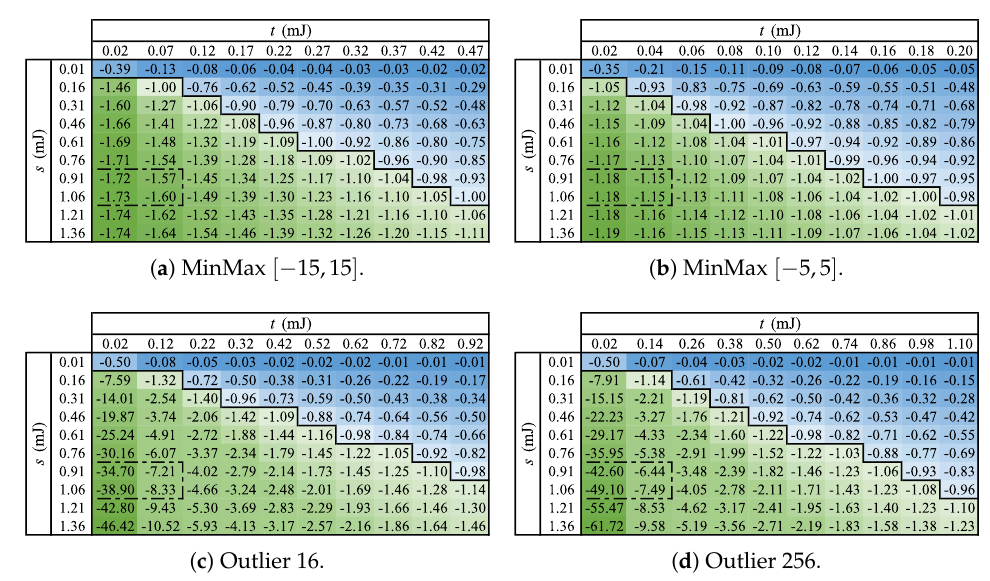
Figure 14. Slope simulations for each test case using energy consumption as the